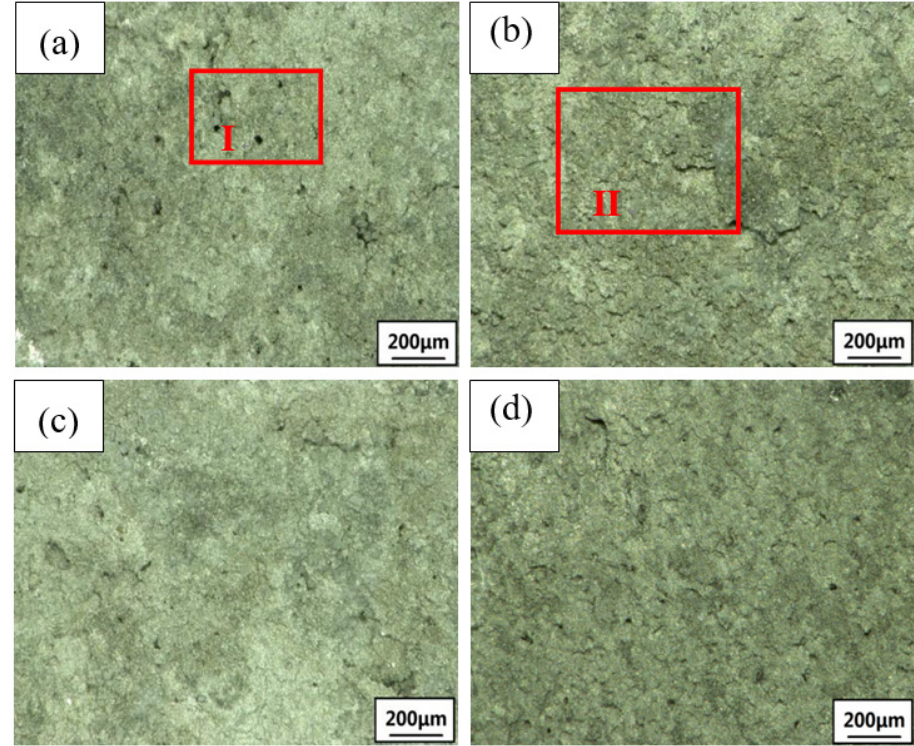
Figure 9. Corrosion morphology of the 2024 FSWed joints with different deformations after 24 h ( a ) 0%, ( b ) 4%, ( c ) 7%, ( d )10%.